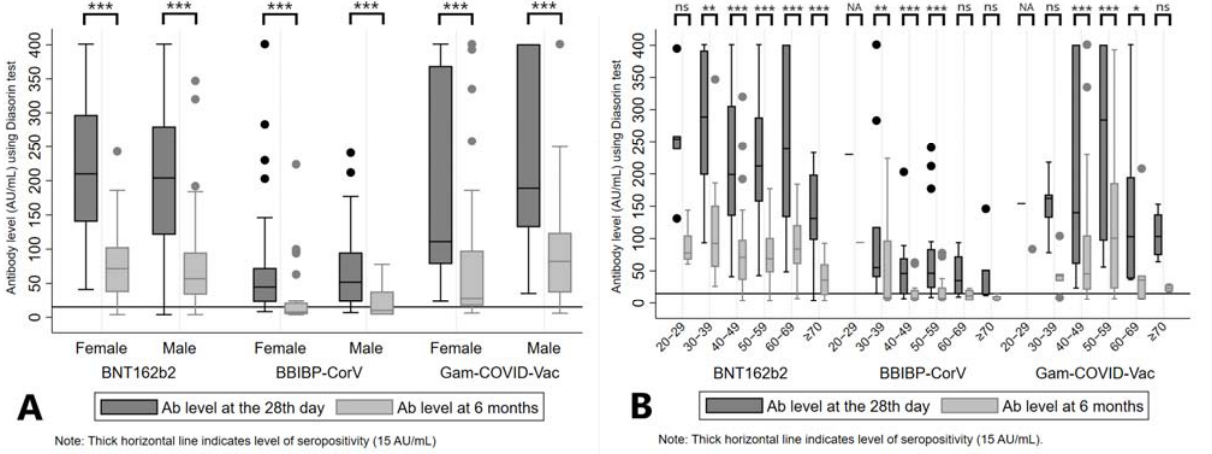
Figure 2. Antibody levels at the 28th day and 6 months after the second dose of vaccine, stratified by sex ( A ) and age groups ( B ) of participants. Legend: *** p < 0.001, ** p < 0.01, * p < 0.05, ns = not significant, NA = not applicable.